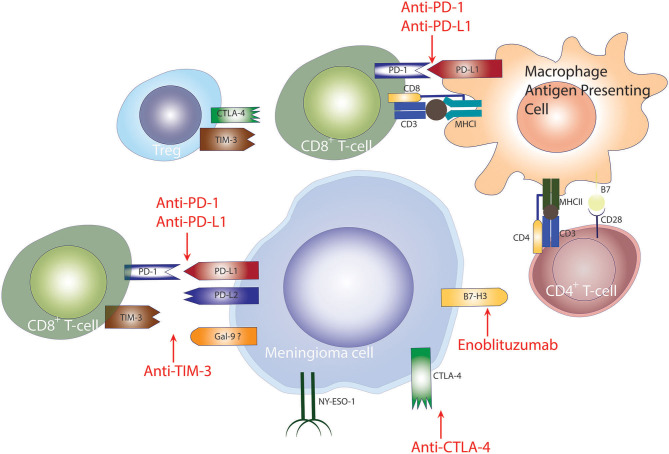
Checkpoint inhibition to treat meningiomas. Checkpoint-mediated mechanisms employed by meningiomas for evasion of the anti-tumor immune response. PD-1 and CTLA-4 signaling diminish T-cell mediated anti-tumor immune response, hampering tumor elimination. Checkpoint blockade of PD-1, CTLA-4, TIM-3 has shown promising results in other cancers.